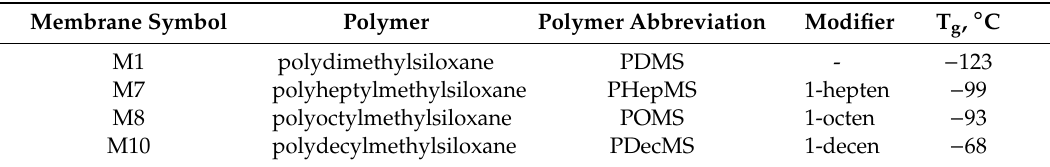
Table 1. Dense polyalkylmethylsiloxane membranes.